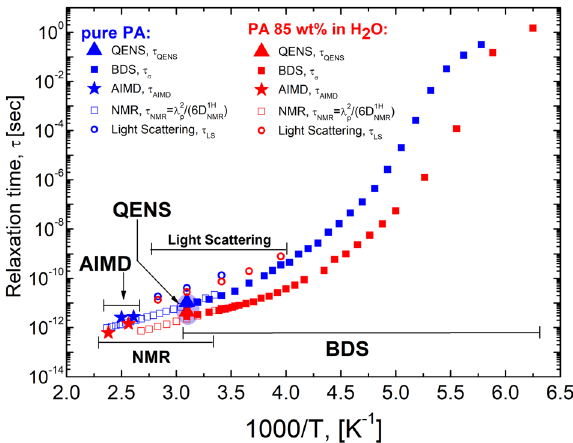
Fig. 3 Temperature dependence of the relaxation time. Temperature dependence of the relaxation time obtained with different methods for pure PA (blue symbols) and PA85 (red symbols): Conductivity relaxation time (closed squares); Structural relaxation time from Light Scattering (open circles); Characteristic relaxation time of proton jumps from QENS (triangles) and from AIMD simulations (stars). Characteristic NMR relaxation time for protons (open squares) are estimated from NMR Þ , assuming a temperature diffusion data, τ NMR ¼ h λ p i 2 = ð 6 D 1H NMR independent h λ p i